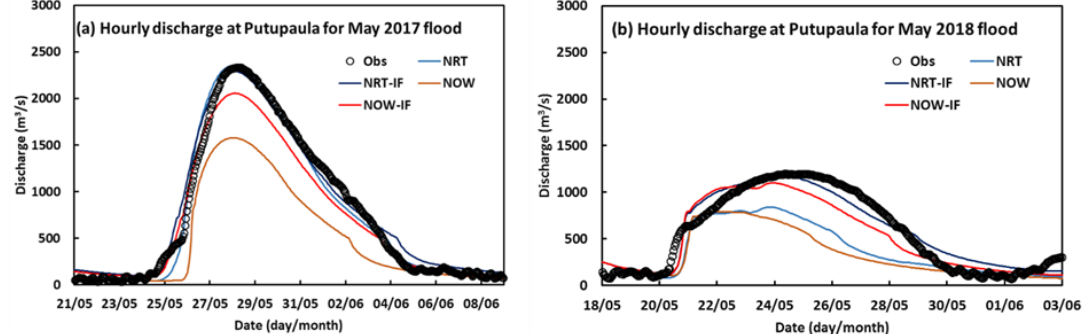
Figure 12. Comparison of model-simulated hourly discharges with observation discharges at Putupaula gauging station from ( a ) 21 May to 9 June 2017 and ( b ) 18 May to 3 June 2018. Table 3. Statistical metrics for the performance of the GSMaP products-derived discharge during 2017 and 2018 flood events .